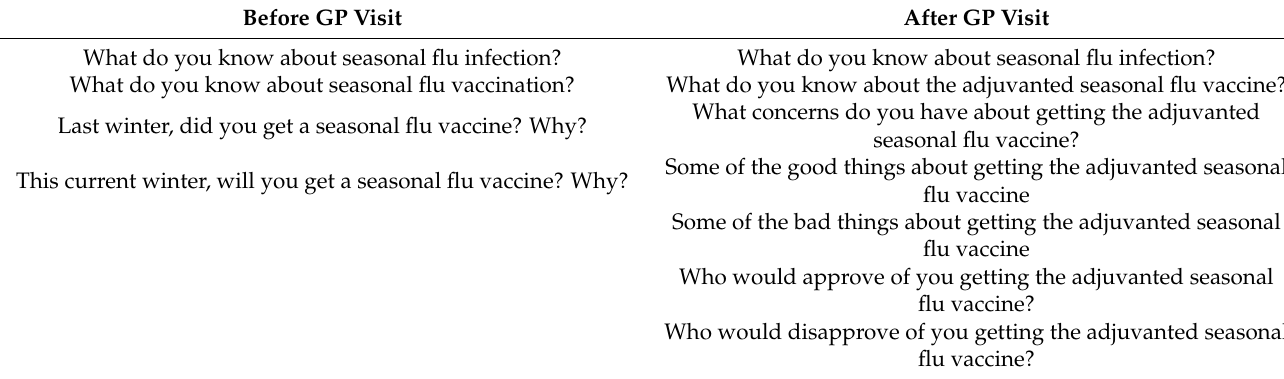
Table 1. Qualitative, open-ended questions included in questionnaires patients filled out before and after a visit with their